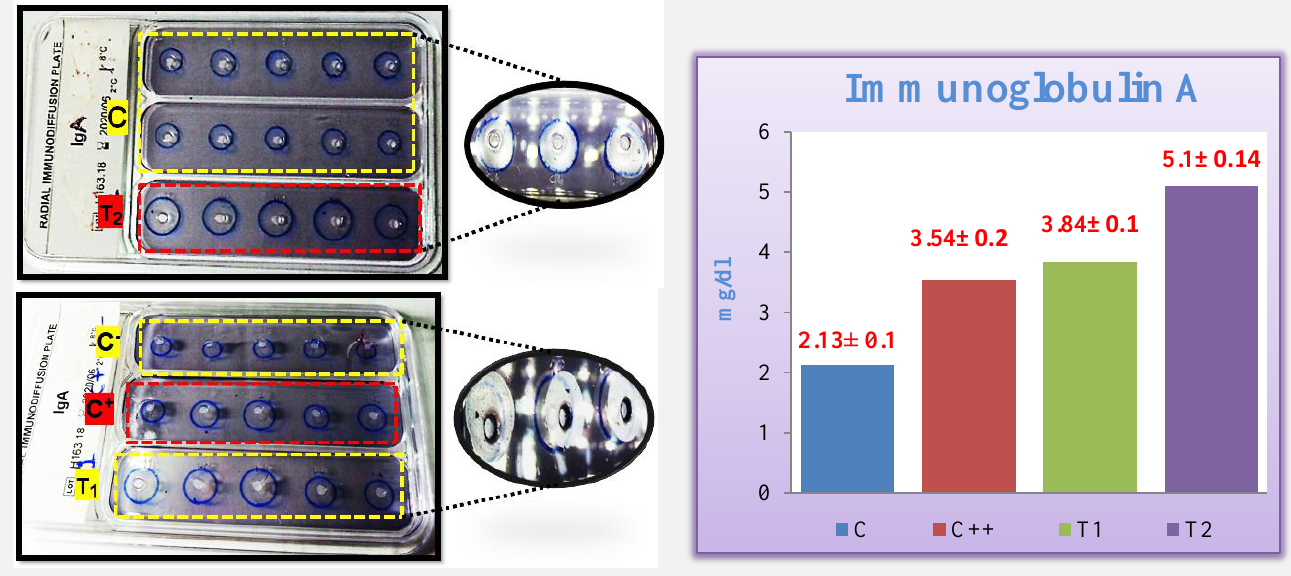
Figure 2. Protective role of synbiotic on serum IgA (mg/dl) against E. coli infection, N=5. Mean±SE. C: control negative group. C+: control positive group. T1: Fenugreek administered to enteritis group. T2: Fenugreek and L. acidophilus administered to enteritis group. Least Significant Difference (LSD) of IgA =